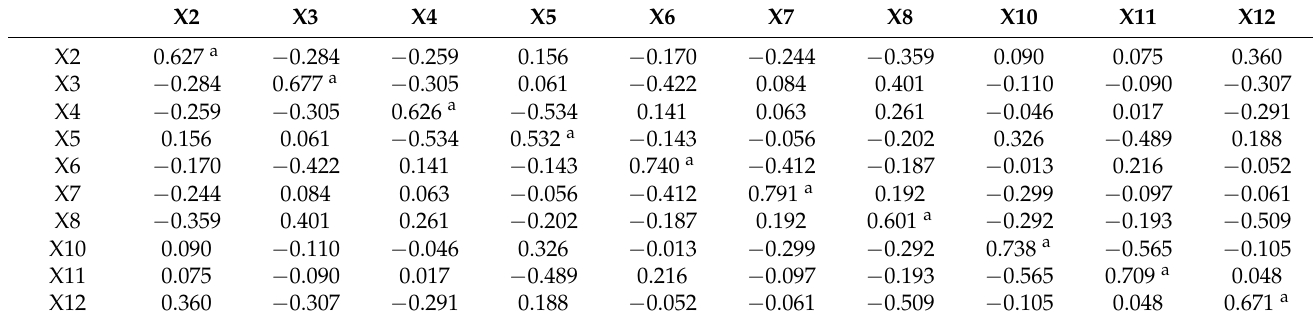
Table 5. Anti-image